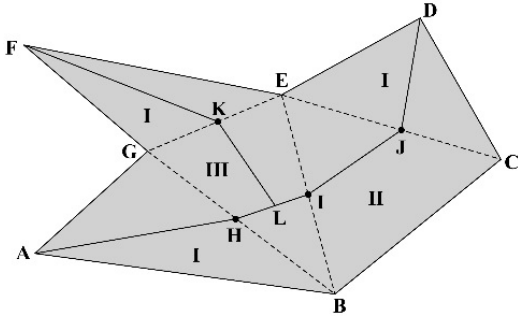
Figure 6. Delaunay triangle classification.